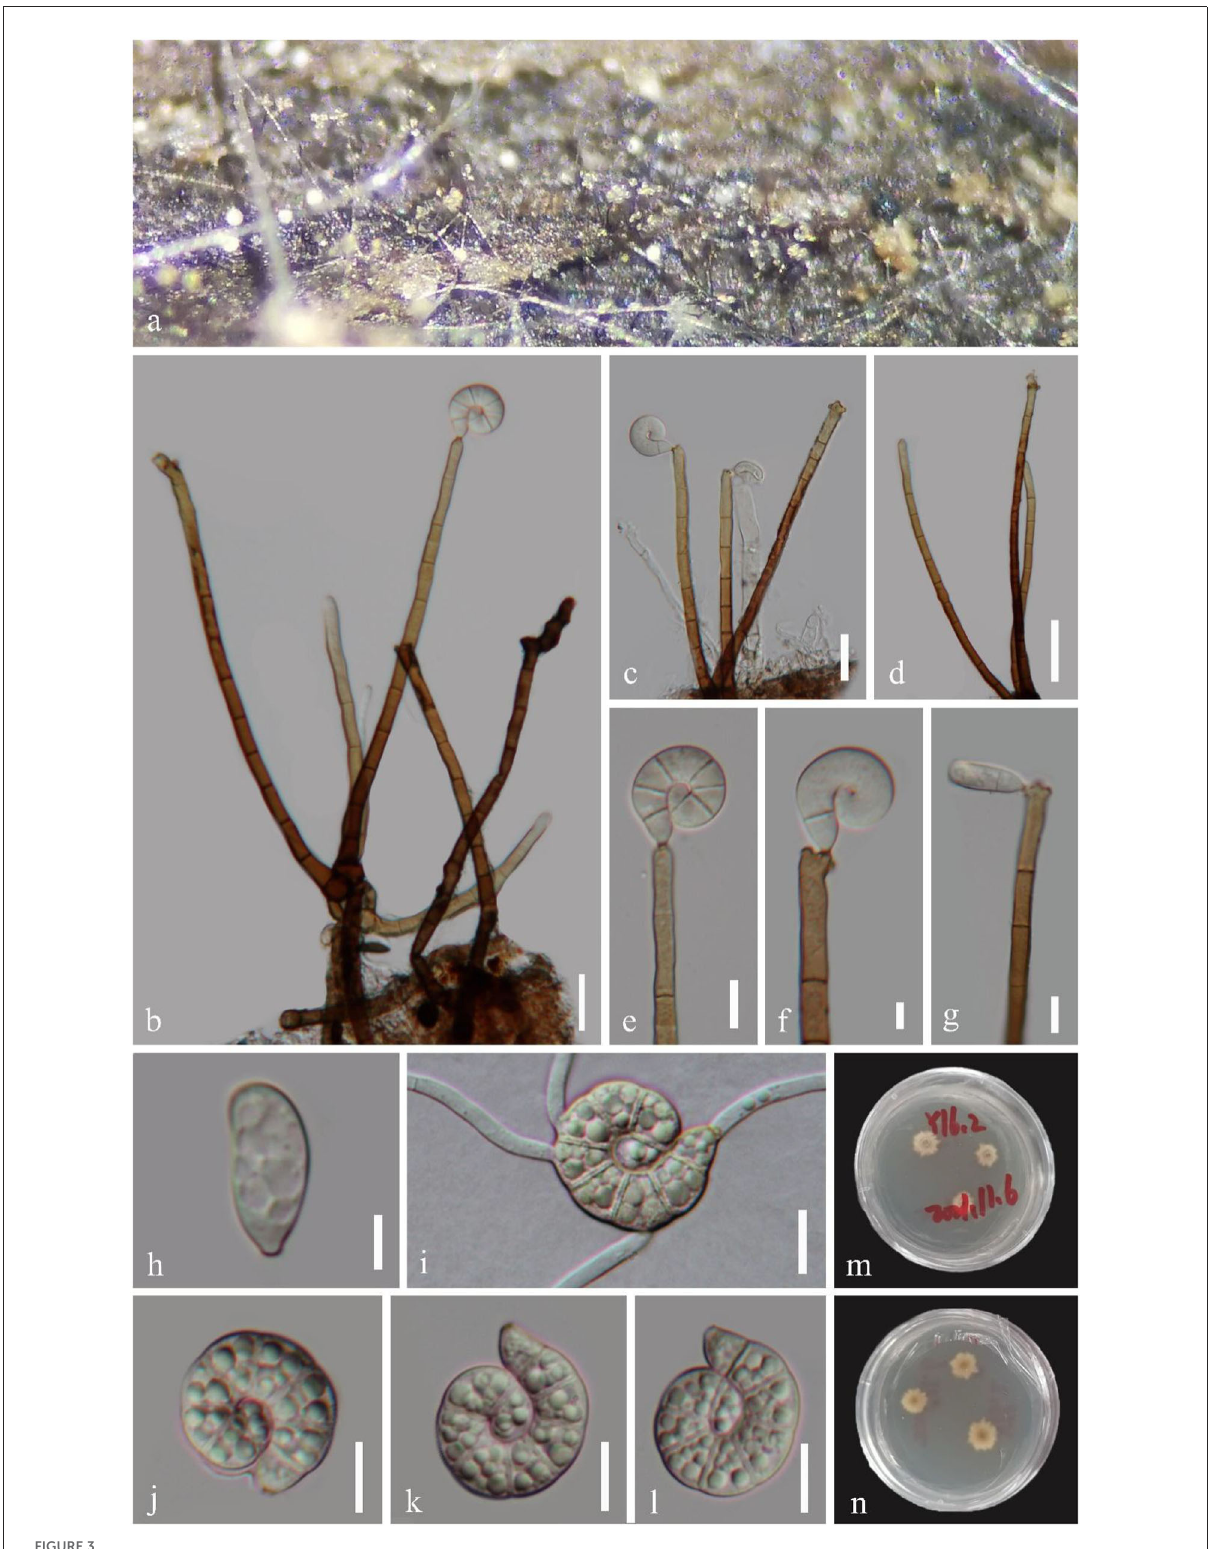
FIGURE3 Helicoma guttulatum (GZAAS 22-2004). (a) Colony on decaying wood. (b–d) Conidiophores and conidia. (e–g) Conidiogenous cells. (i) Germinating conidium. (h,j–l) Conidia. (m,n) Colonies on PDA observed from above and below. Scale bars: (b–d) = 20 µ m, (e–j,i–l) = 10 µ m, and (h) = 5 µ